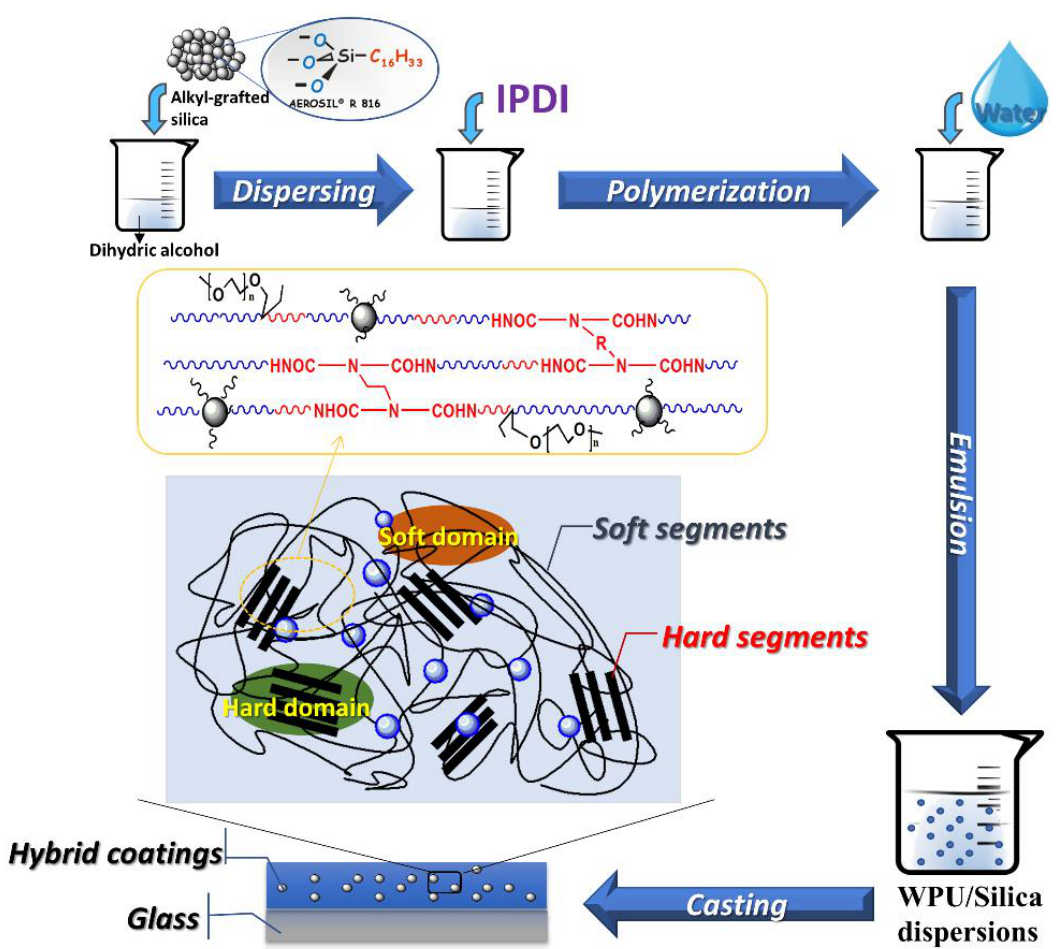
Figure 1. Preparation of waterborne polyurethane/Silica (WPU/Silica) dispersions with high solid content and their coatings.